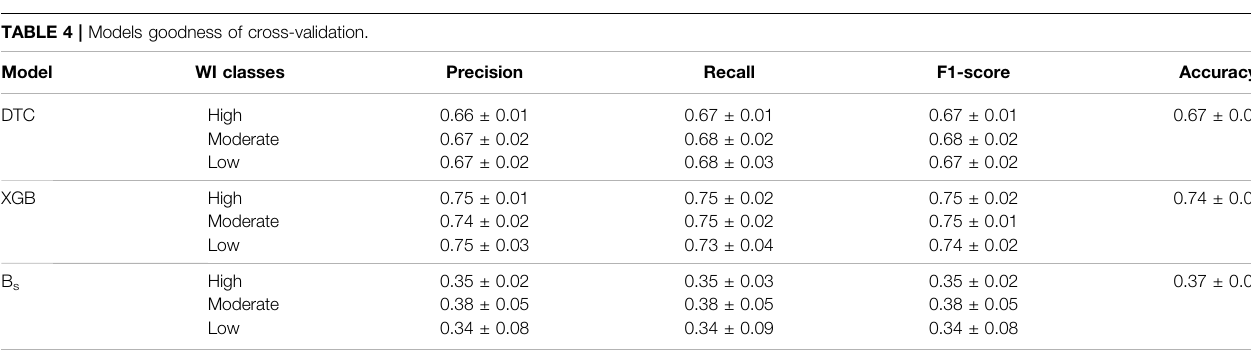
TABLE 4 | Models goodness of